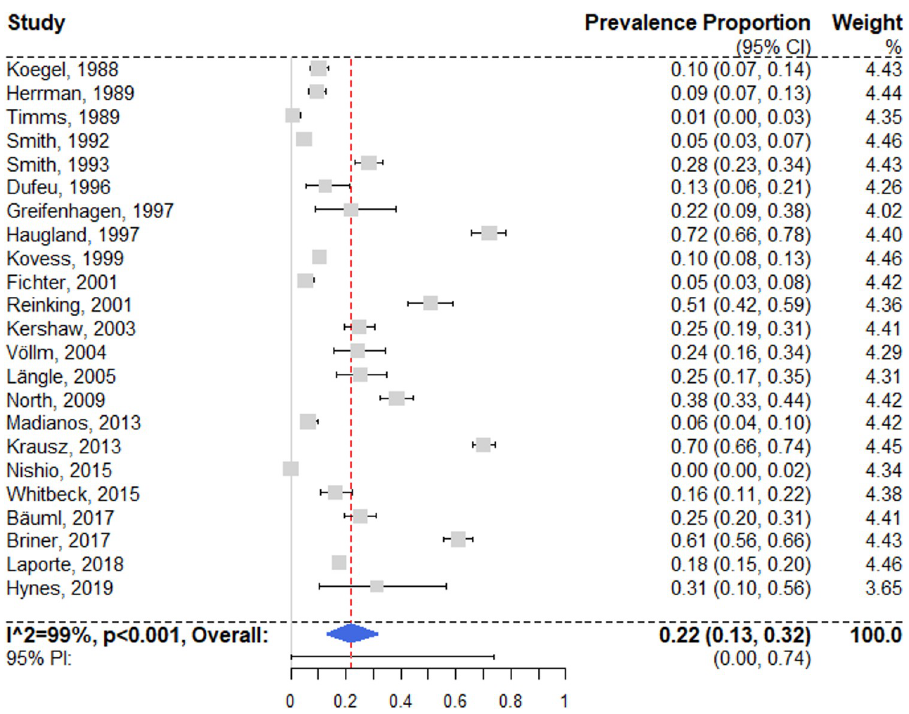
Fig 7. Forest plot of prevalence estimates of drug use disorders. AU : Basedonthereferenceslist ; IbelievethefollowingareerrorsinFig 7 : ð 1 Þ Kershaw ; 2000 shouldbeKershaw ; 2003 ½ 61 �ð 2 Þ LaPorteshouldbeLaporte ½ 29 �ð 3 Þ Hynes ; 2018 shouldbeHynes ; 2019 ½ 62 � PleasefixtheseerrorsinFig 7 : Asecond (cid:0) bestsolutionwouldbetoequatethesemisidentifiedrefswiththeircorrectreferencenumbersinthefigurelegend Analytic weights are from random effects meta- analysis. Grey boxes represent study estimates; their size is proportional to the respective analytical weight. Lines through the boxes represent the 95% CIs around the study estimates. The blue diamond represents the mean estimate and its 95% CI. The vertical red dashed line indicates the mean estimate. CI, confidence interval; PI, prediction interval; RE: random effects.